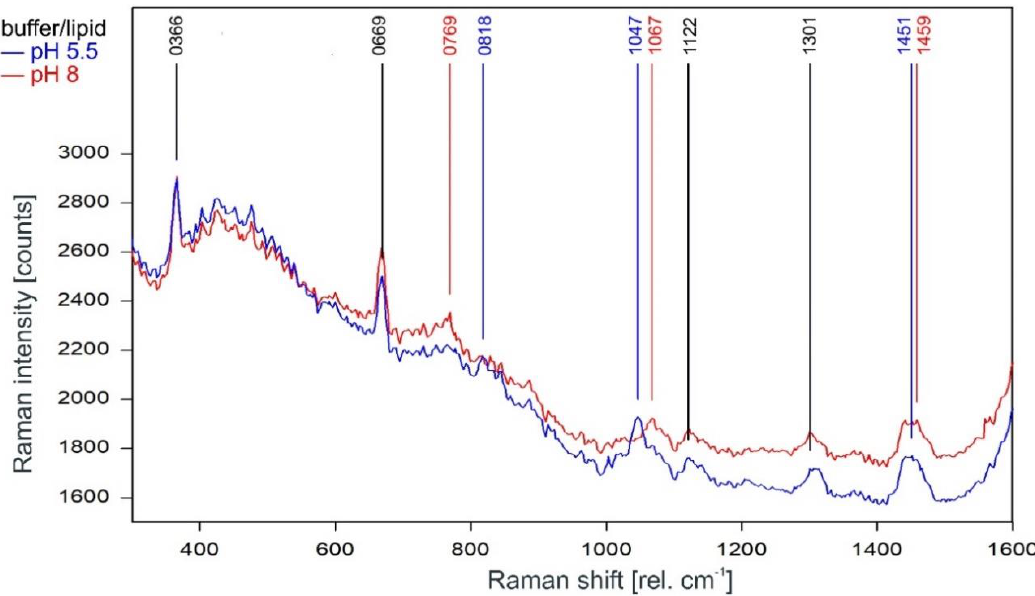
Figure 4. Raman spectrum of the buffer–lipid solution between 300 and 1600 rel. cm −1 at pH 5.5 (blue) and pH 8 (red) as recorded. Raman lines shared by the spectra are marked in black.